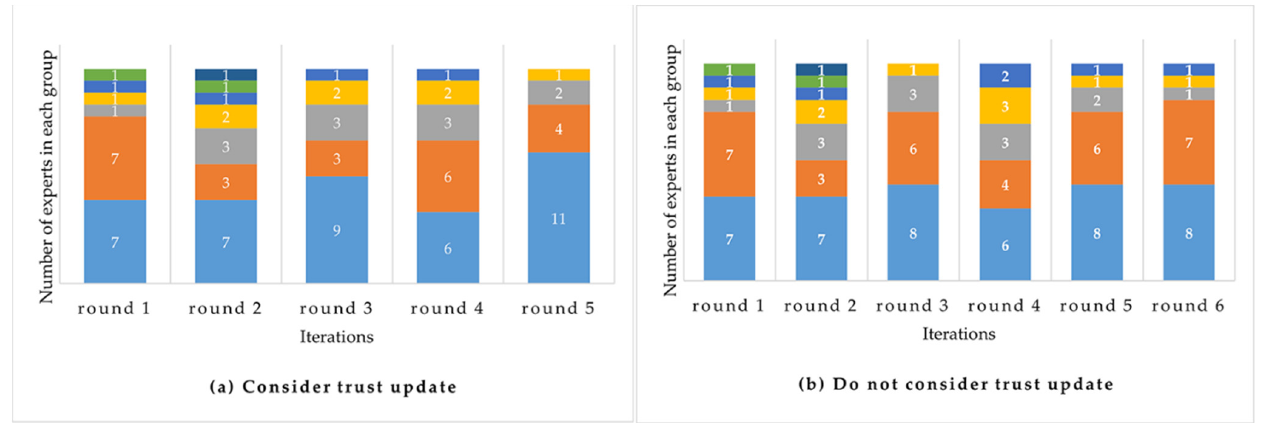
Figure 7. Clustering at each opinion interaction stage.